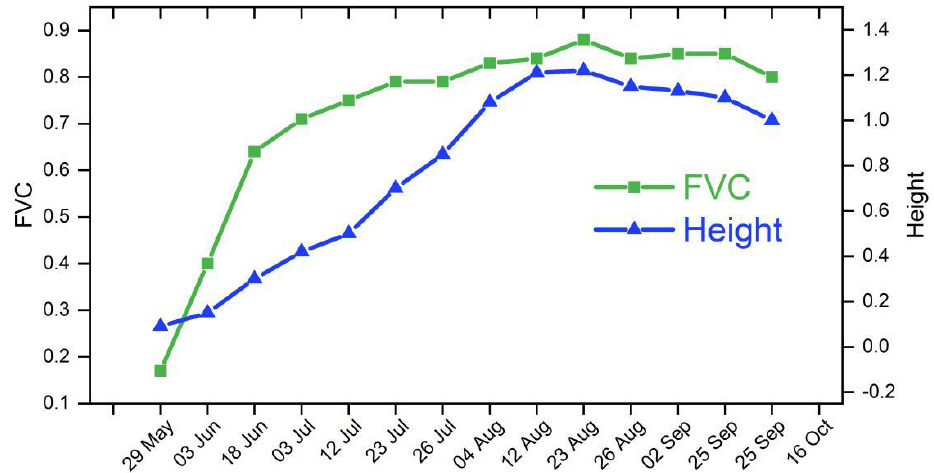
Figure 2. The fraction of vegetation cover (FVC) and plant height of the flooded vegetation growing season.